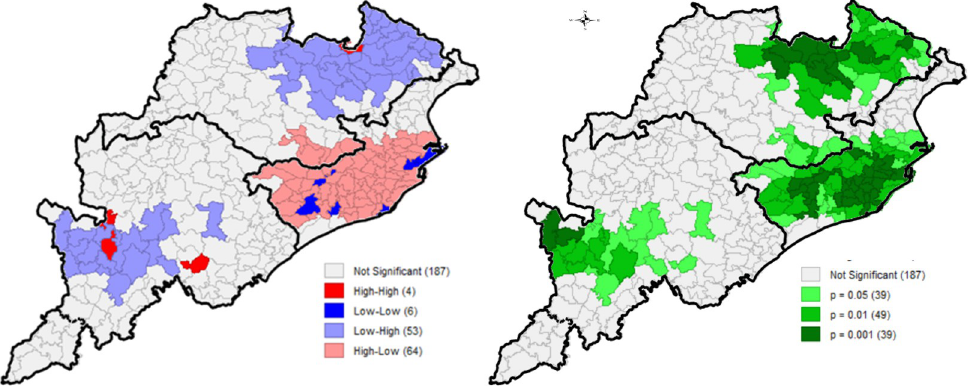
Fig 4. Bivariate LISA cluster and significance map of underweight vs improved sanitation, block-wise, CCM-II, 2014– 15, Odisha, India.